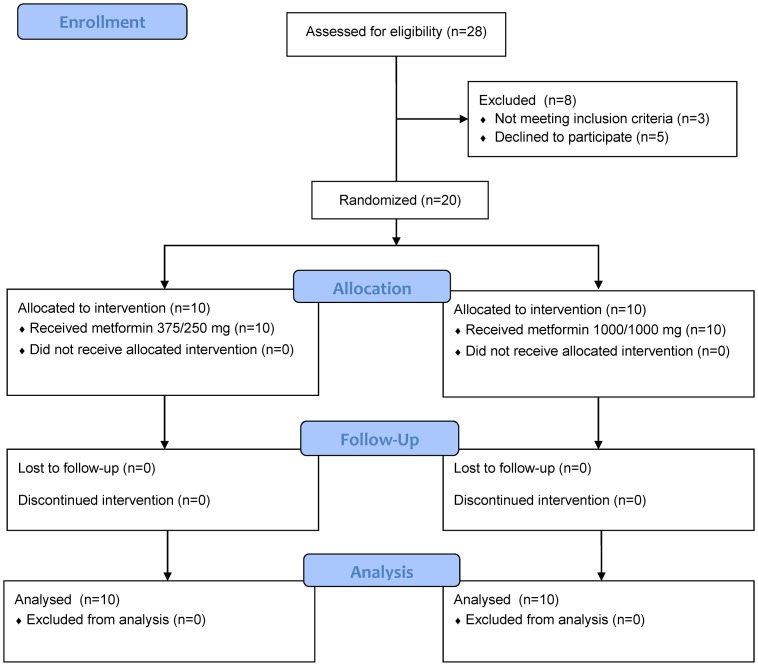
CONSORT flowchart.